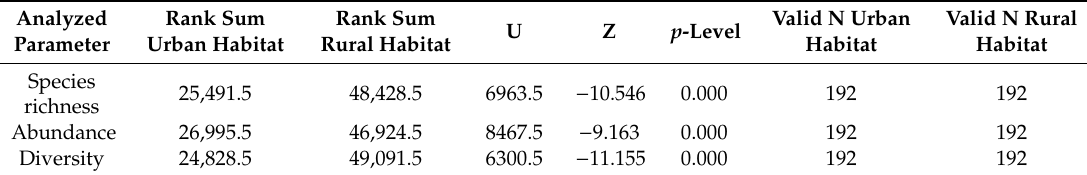
Table 2. E ff ect of habitat type on total species richness, abundance, and diversity assessed by Mann–Whitney U test (U and Z are measures of the significance of the di ff erence between the samples, based on the sum of ranks and distance from the mean; N is the number of the samples (trees) analyzed). Analyzed